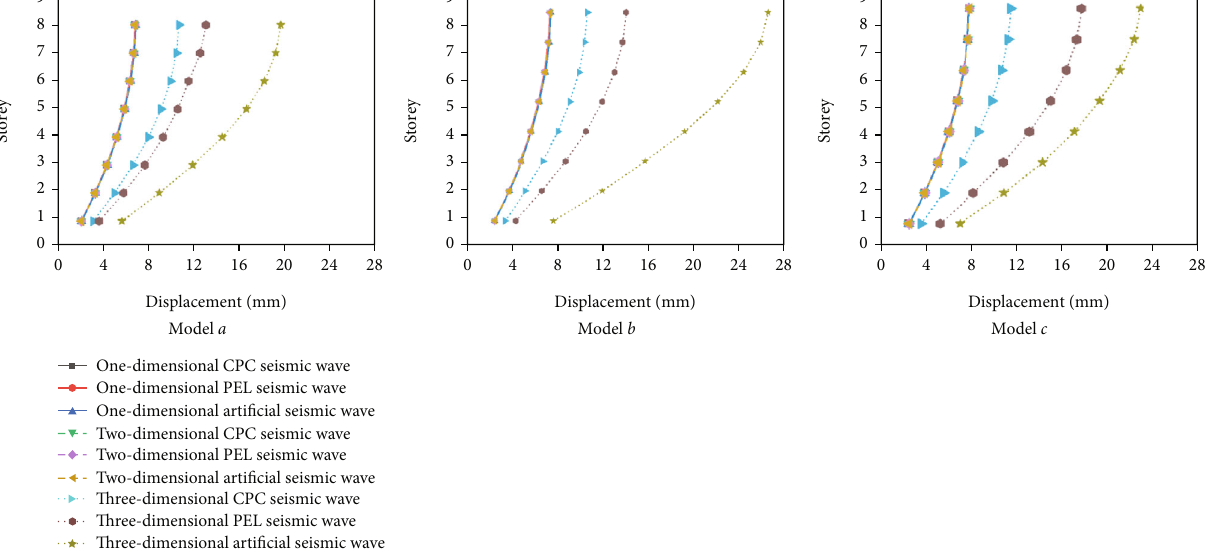
Figure 12: Comparison of fl oor displacements of di ff erent models in Z